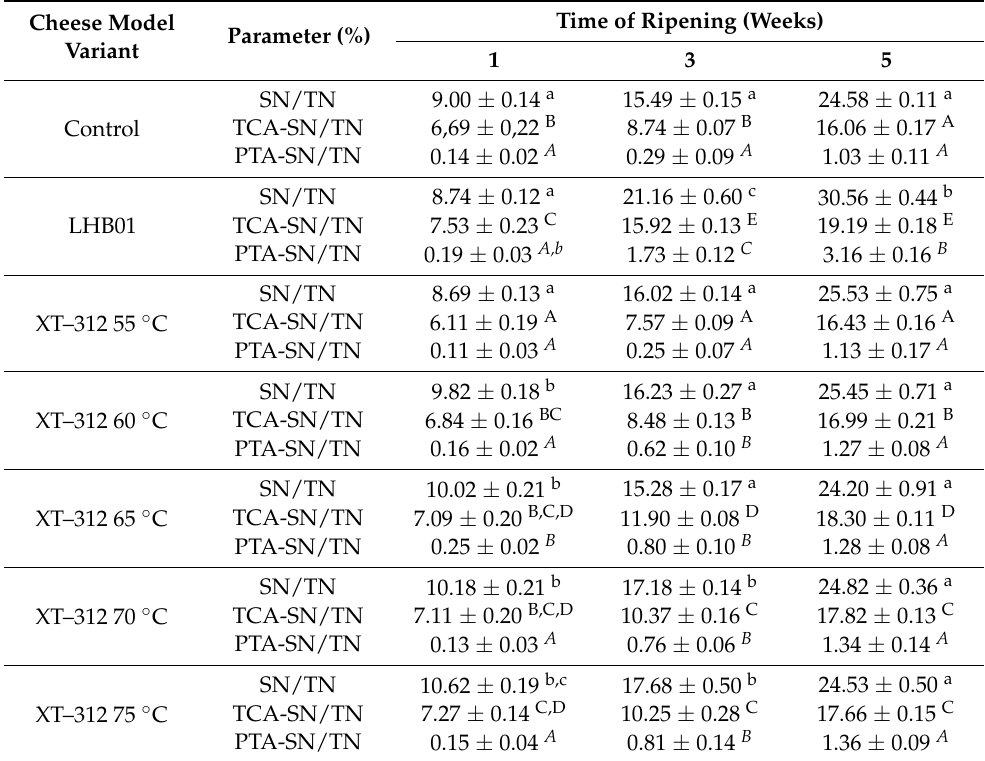
Table 3. The change of ripening parameters of experimental cheese